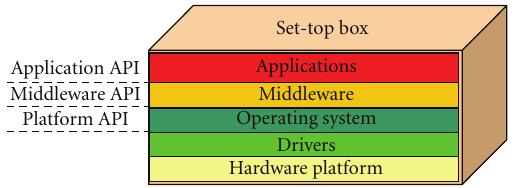
Figure 1: Set-top Box Software Layer Architecture